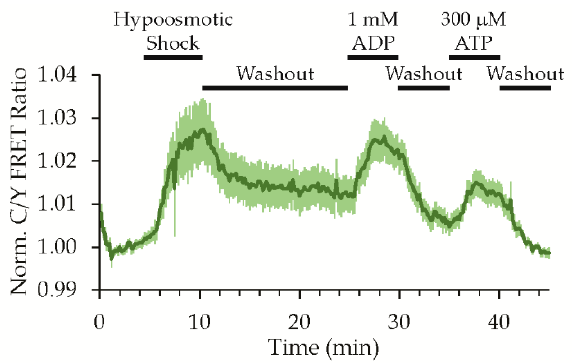
Figure 10. ADPrime detects hypoosmotic shock-induced nucleotide release. Time-course response of ADPrime expressed on live HEK293 cells with continuous superfusion and wash-in of solutions as indicated (mean ± 95% CI, 62 cells, nine experiments).